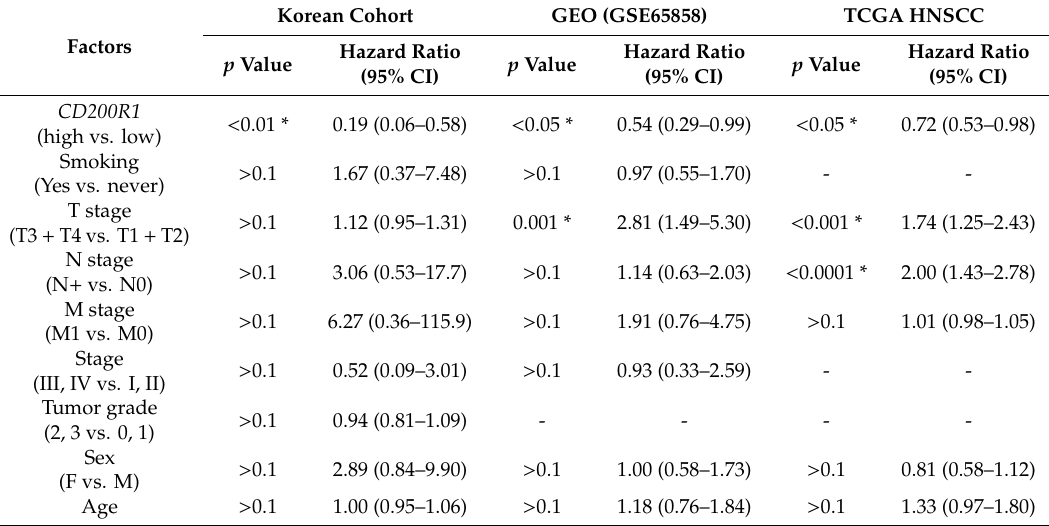
Table 2. Multivariate analysis of the overall survival in the Korean cohort and the GEO (GSE65858)